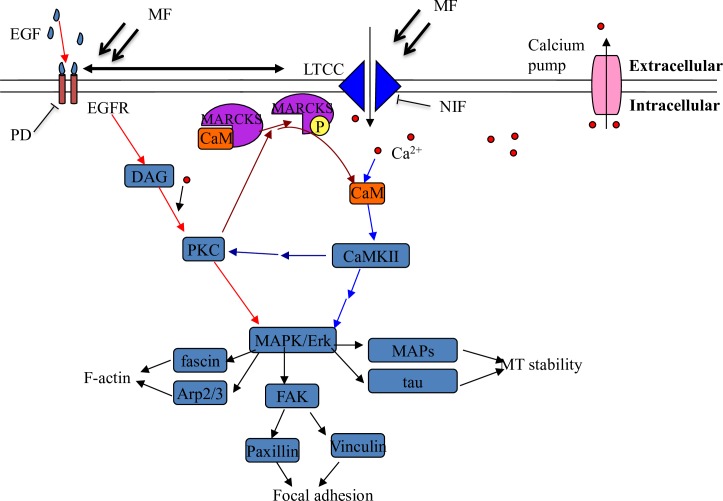
A schematic of how MF affects microtubule stability via EGFR and calcium pathways and the cross talks between the two.Arrows with blunt ends indicate inhibition relation. Red arrows: the EGFR-PKC-MAPK/Erk pathway [3–5]; blue arrows: the LTCC/CaMKII-MAPK/Erk pathway [46, 47]; dark red arrows: influence of the EGFR-PKC-MAPK/Erk pathway on the LTCC/CaMKII-MAPK/Erk pathway [43]; dark blue arrows: influence of LTCC/CaMKII-MAPK/Erk pathway on the EGFR-PKC-MAPK/Erk pathway [44–47]. The focal adhesions are also under the regulation of the MAPK/Erk pathway [50, 62].